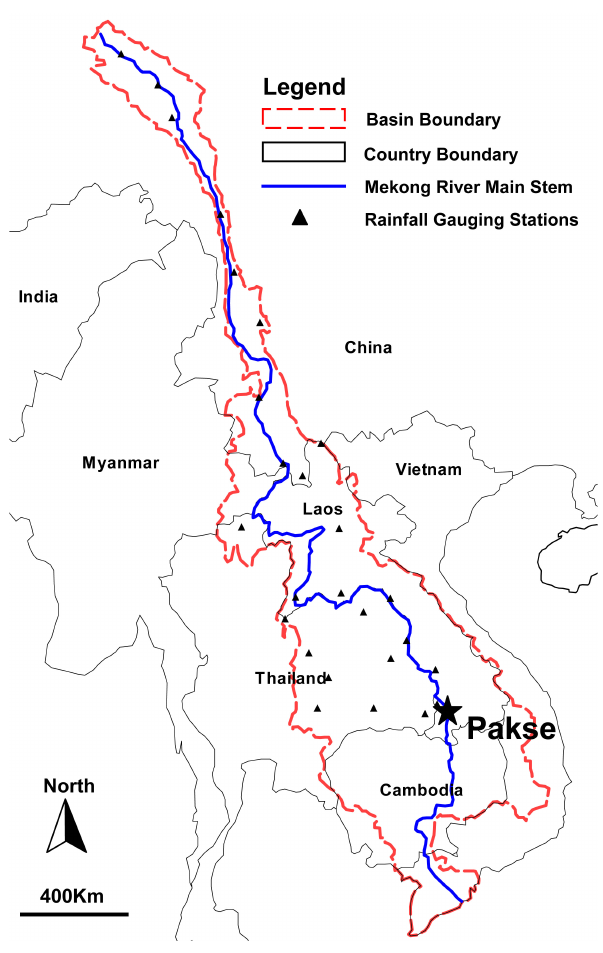
Fig. 2. Location of Pakse in the Mekong Basin and rainfall gauging stations.